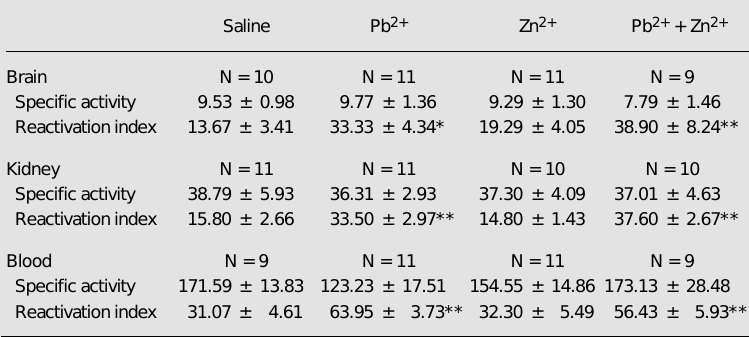
Table 1. Brain, kidney and blood ALA-D specific activity and reactivation index with DTT in 13-day- old rats exposed to lead acetate and/or zinc